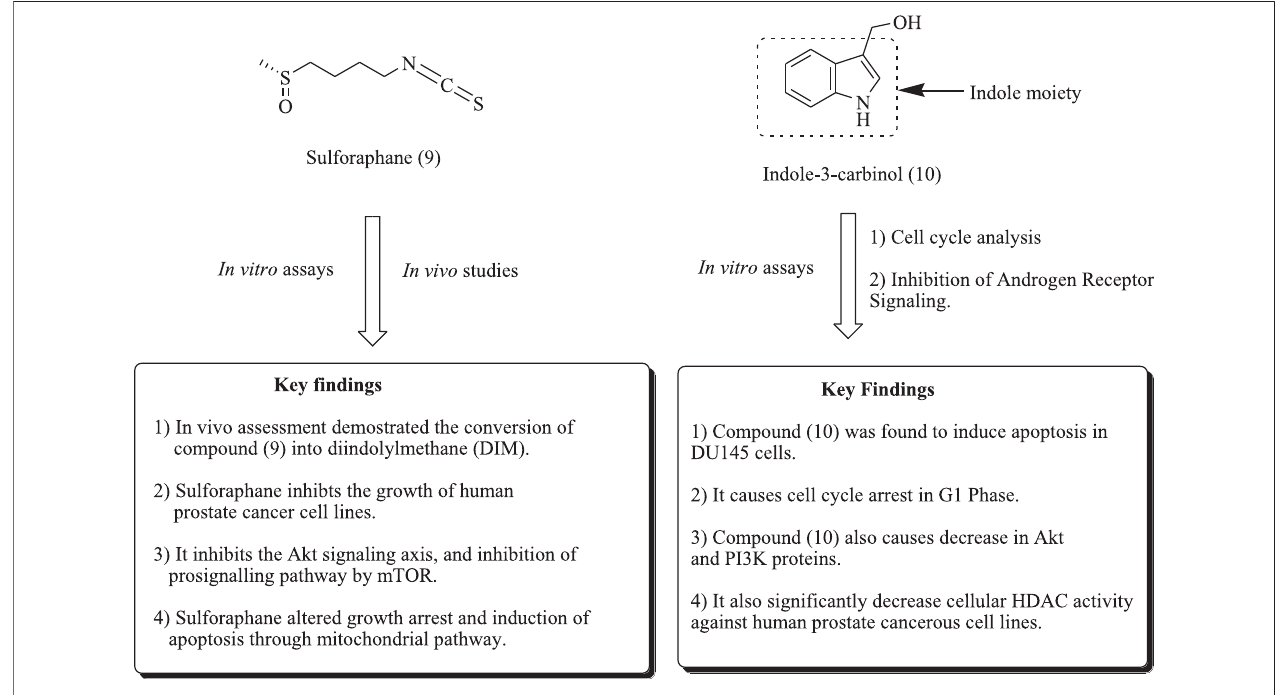
FIGURE 8 | Structures of sulforaphane and indole-3-carbinol along with mechanistic insights.